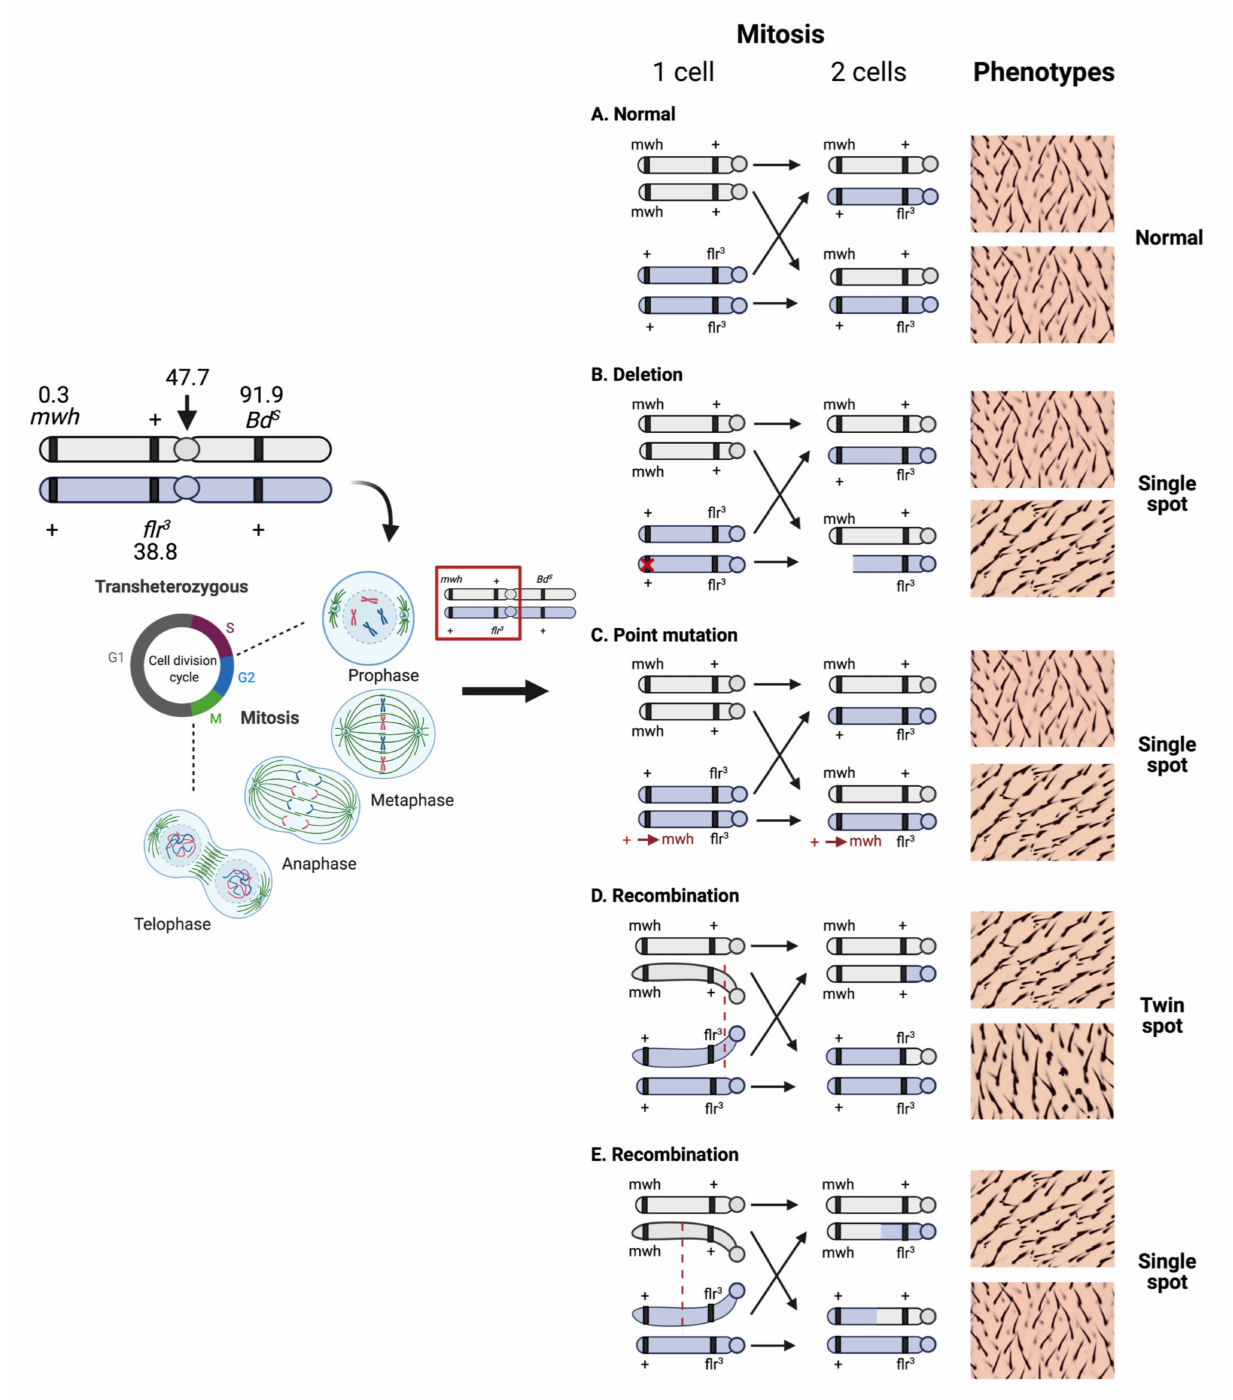
Figure 3. The schematic diagram illustrating the molecular mechanisms for mutant spots (single or twin spots) formation by deletion, point mutation, and recombination detected by wing spot test (adapted from